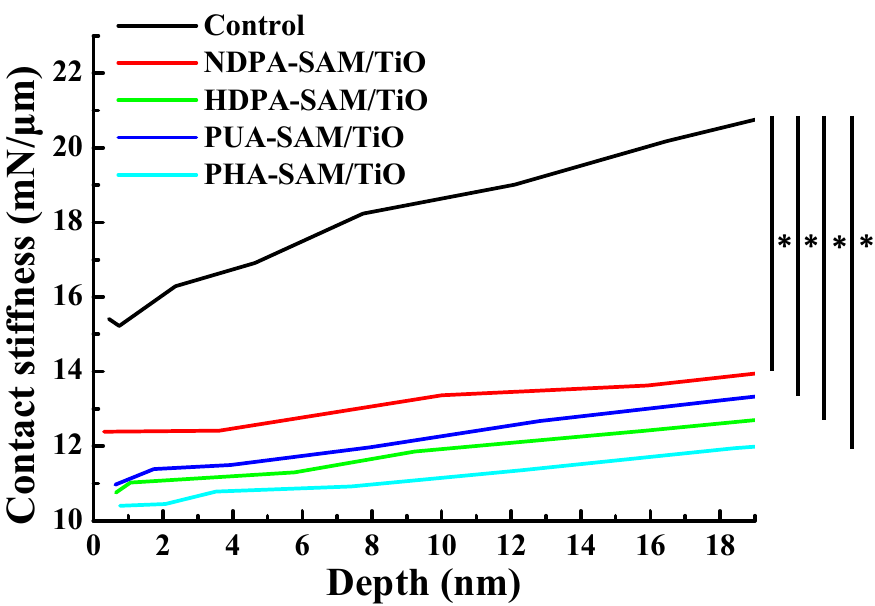
Figure 7. The surface contact stiffness results of the investigated samples after nano-indentation (* p < 0.05).